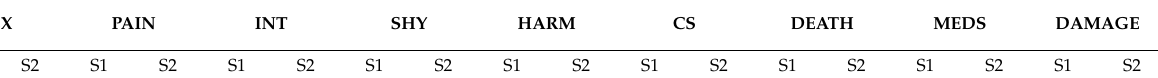
Table 5. Correlations among the CFQ subscales and total score for Study 1 (S1) and Study 2 (S2).